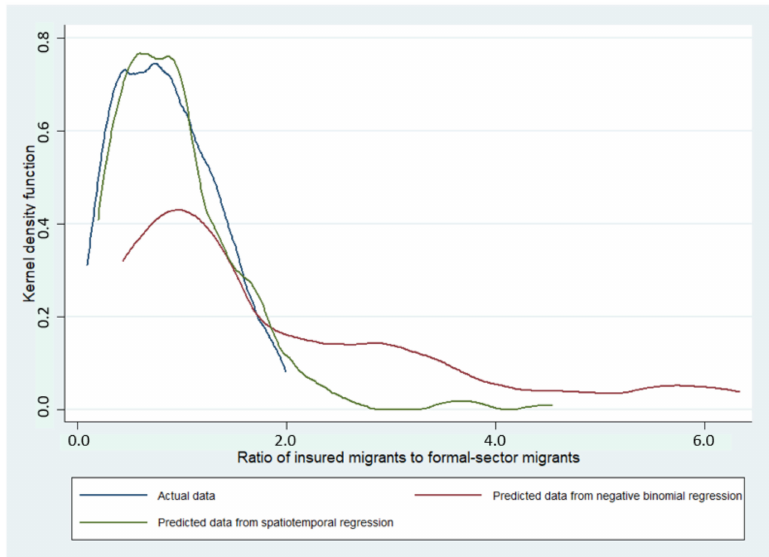
Figure 5. Kernel density plot of the ratio of insured migrants to formal-sector migrants from NB regression and spatiotemporal model and the actual data.